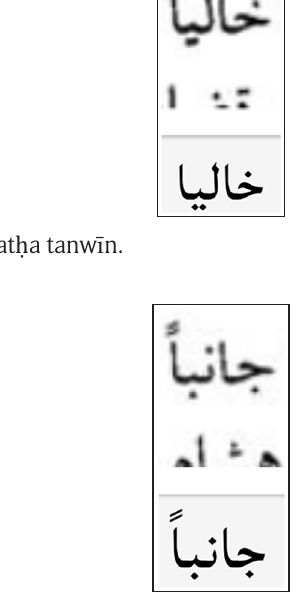
a tanw ī n from same page as Figure ḥ